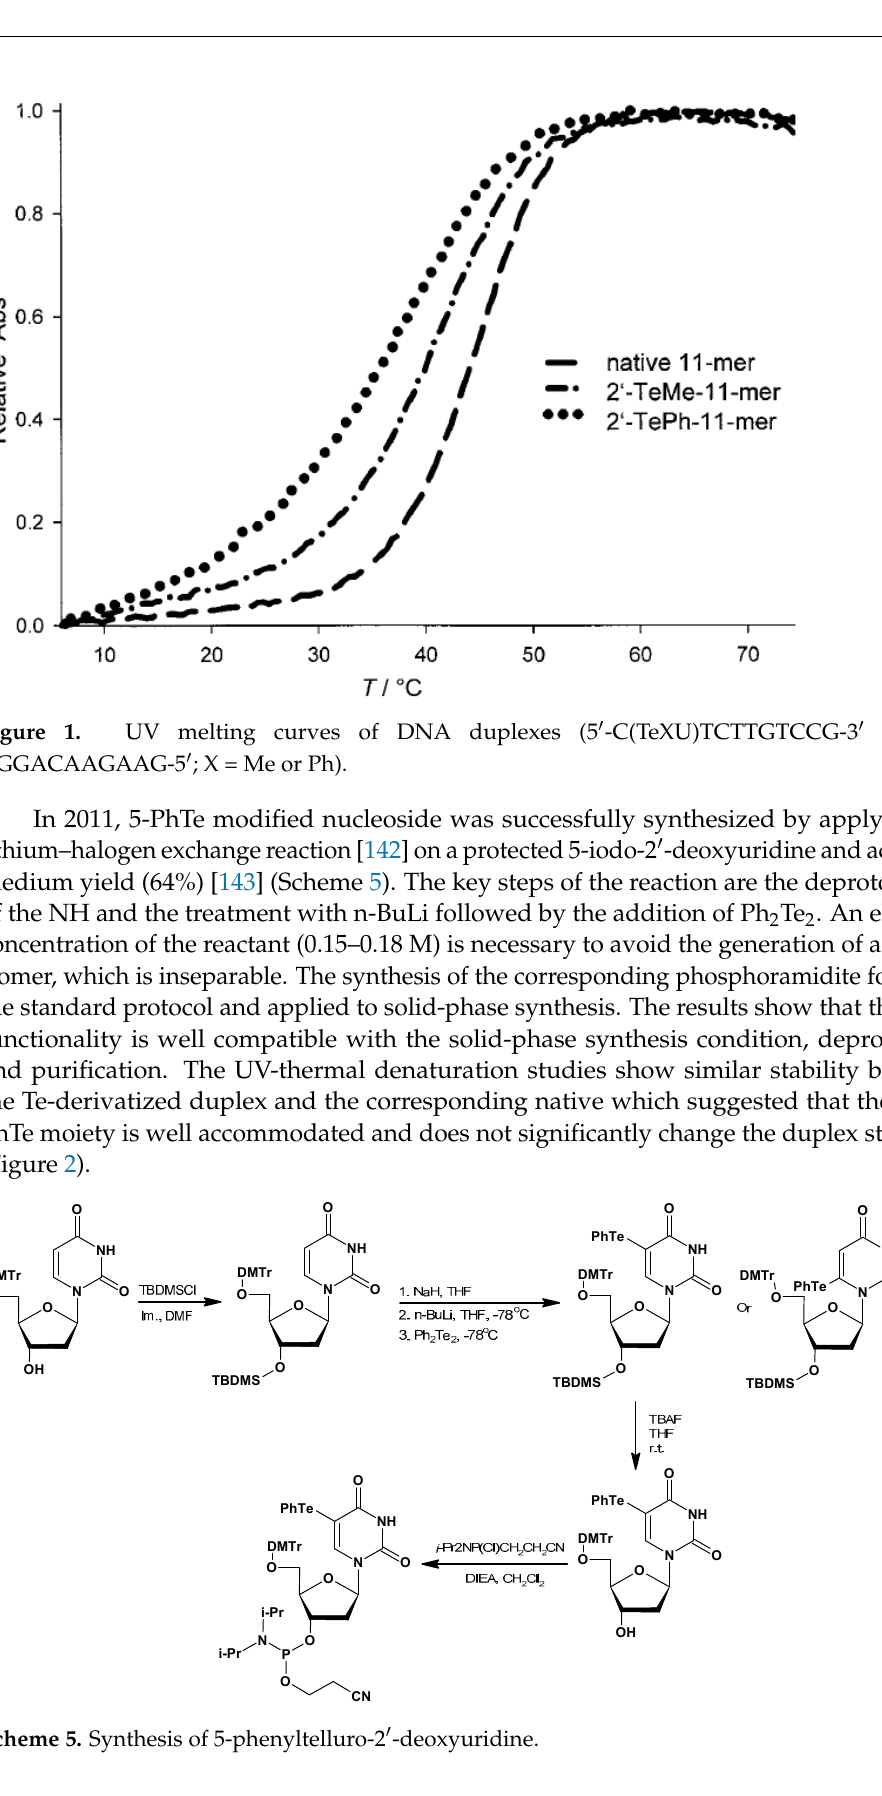
Figure 2. Crystal photo of the Te-DNA octamer [5 ′ -G(2 ′ -SeMe-dU)G( Te T)ACAC-3] 2.